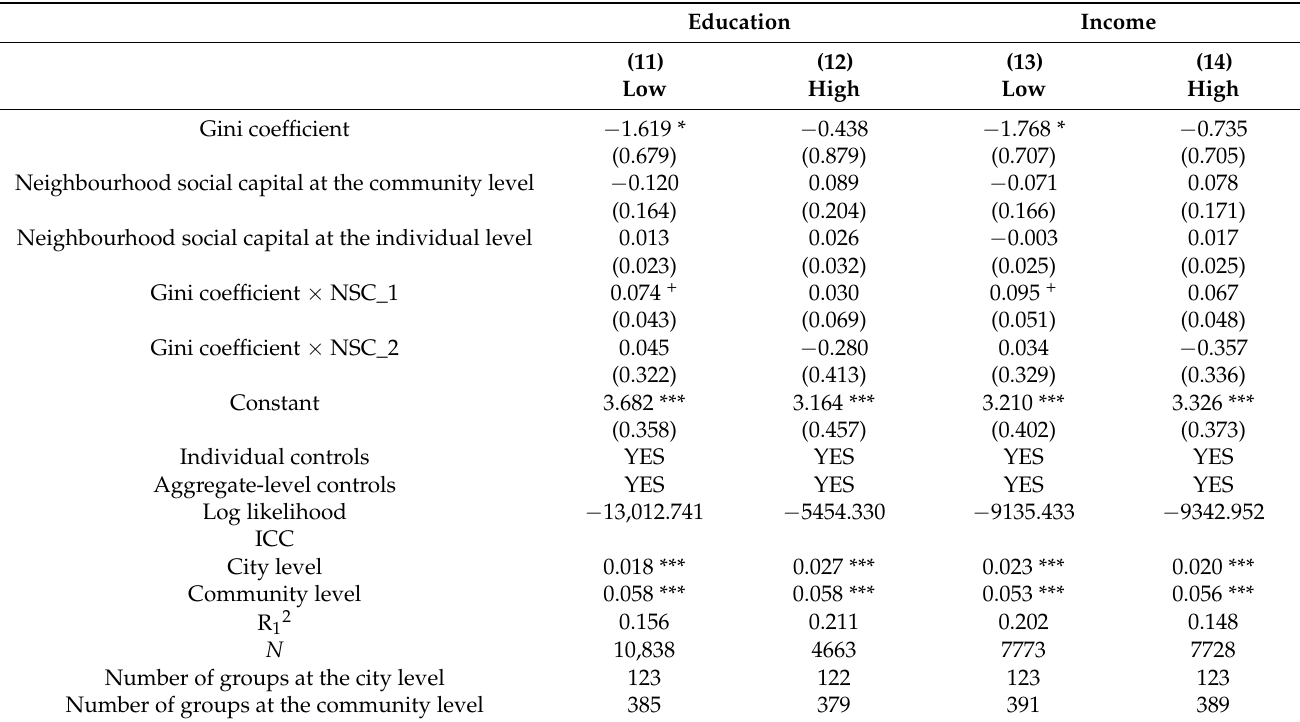
Table 6. The moderating effects for